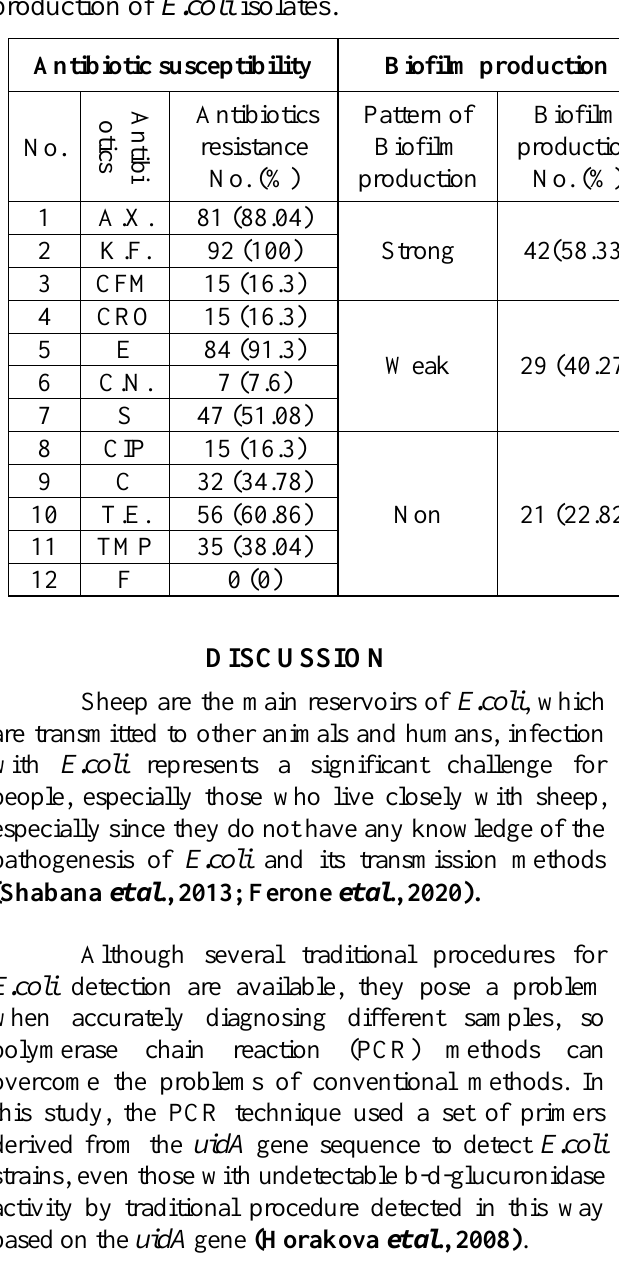
Table 1: Antibiotic susceptibility and biofilm production of E.coli